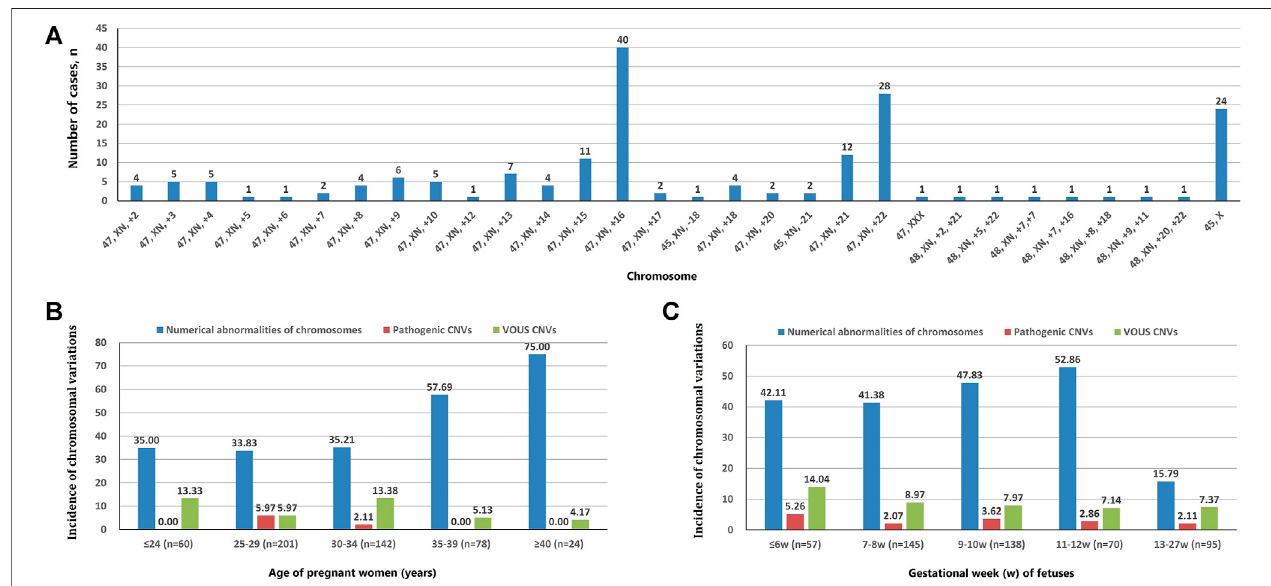
FIGURE 1 | Chromosomal variation analysis. (A) The number of cases of chromosome aneuploidies (XN (cid:2) XX or XY). (B) Incidence of numerical abnormalities of chromosome, pathogenic CNVs, and VOUS CNVs depending on age of pregnant women. (C) Chromosomal variations in miscarriage samples of different gestational